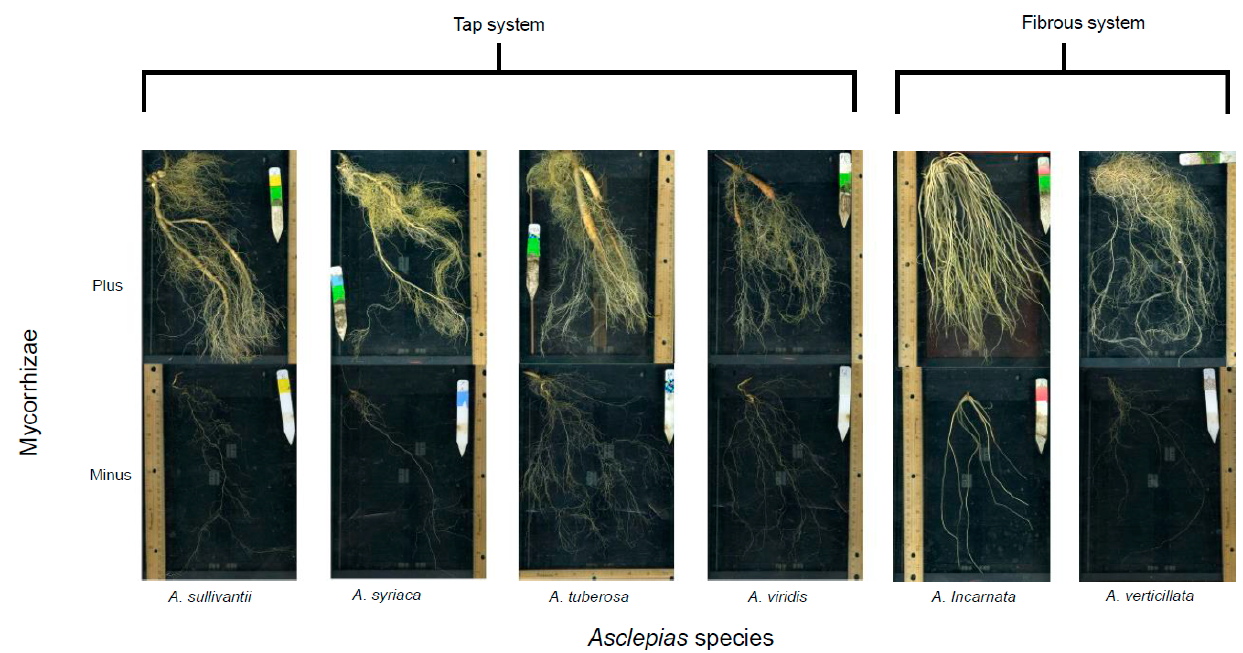
Figure 1. Imagery shows a subset of plants from the experiment. The top panel represents roots with mycorrhizae, the bottom panel represent roots void of mycorrhizae. Mycorrhizae had pronounced effects on root systems. In tap-root systems, the dominant root was more likely to be modified into a tuber-like structure.